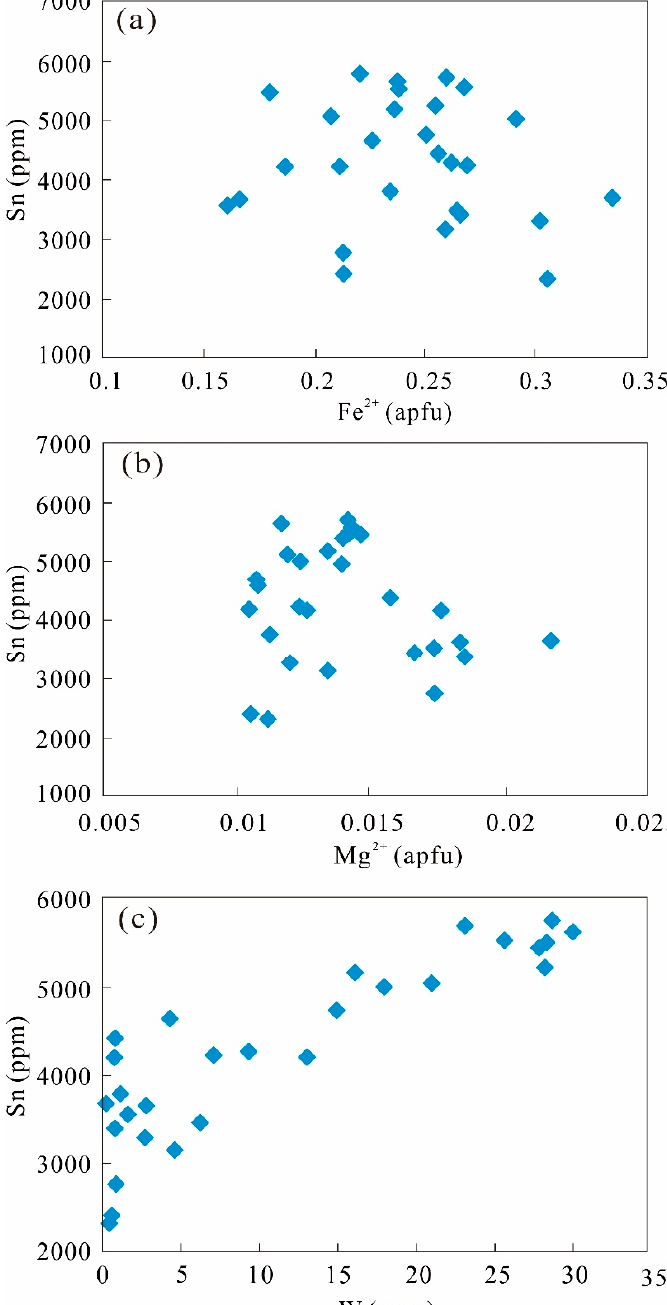
Figure 8. Geochemical compositions of garnets from Xianghualing. Plots of ( a ) Sn (ppm) vs. Fe 2+ (apfu), ( b ) Sn (ppm) vs. Mg 2+ (apfu), and ( c ) Sn (ppm) vs. W (ppm). apfu = atoms per formula unit.